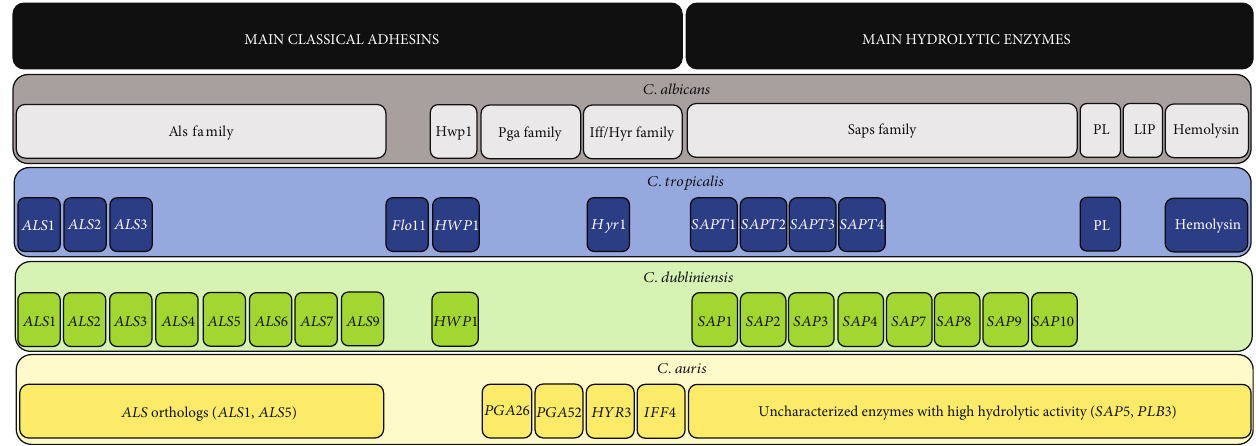
Figure 2: Main virulence factors of selected yeasts of the genus Candida